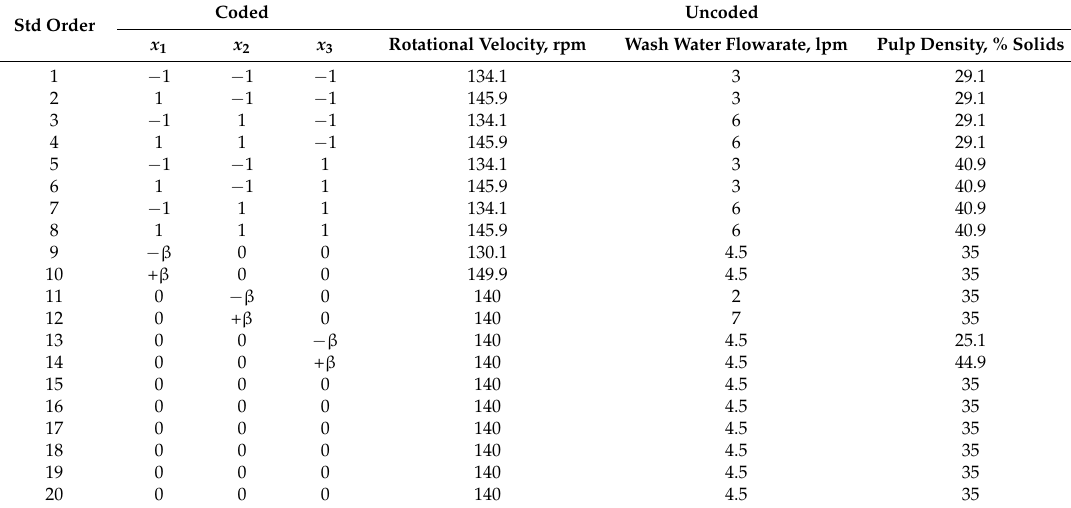
Table 2. Summary of experimental runs in CCRD experimental design